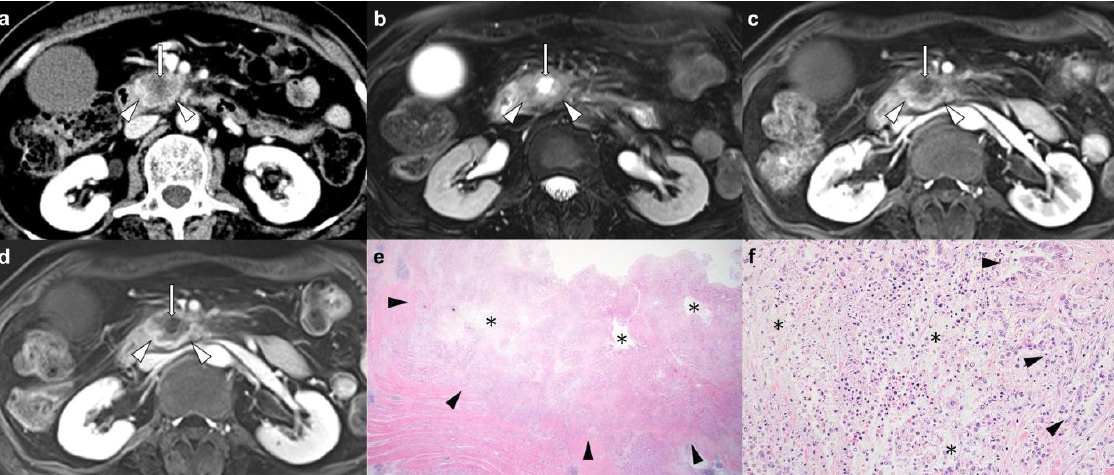
Figure 1. Pancreatic ductal adenocarcinoma in the head of the pancreas in a 65-year-old woman. ( a ) An axial contrast-enhanced CT image shows a 4.5 cm hypoenhancing pancreatic head mass (arrowheads) with centrally located nonenhanced tumoral tissue judged to be the presence of CT-detected necrosis (arrow). ( b ) An axial T2-weighted MR image with fat suppression shows a pancreatic head mass (arrowheads) accompanied by an intratumoral fluid-containing area with a bright signal intensity at the central location (arrow). On axial dynamic contrast-enhanced T1-weighted MR images, ( c ) portal-venous and ( d ) delayed phases show a hypoenhancing pancreatic head mass (arrowheads) with nonenhanced intratumoral tissue, which is judged to be MRI-detected necrosis (arrow). ( e , f ) Micrographs show intratumoral necrosis (asterisks) surrounded by carcinoma cells forming glands (black arrowheads) (hematoxylin and eosin stain, ×12.5 ( e ) and ×200 ( f )). In this patient, the presence of imaging necrosis was consistent between CT and MRI, and areas of necrosis accounted for approximately 20% of tumors based on histopathology. Local tumor recurrence was detected on follow-up CT 2 months after margin-negative resection (not shown), and the patient died 6 months later.